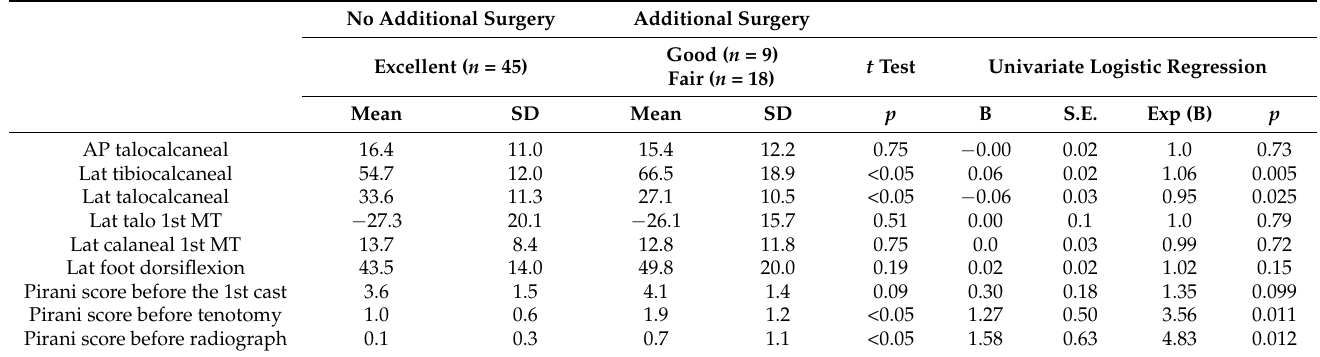
Table 3. Angles measured on radiographs and Pirani scores in patients with and without need for additional surgery.